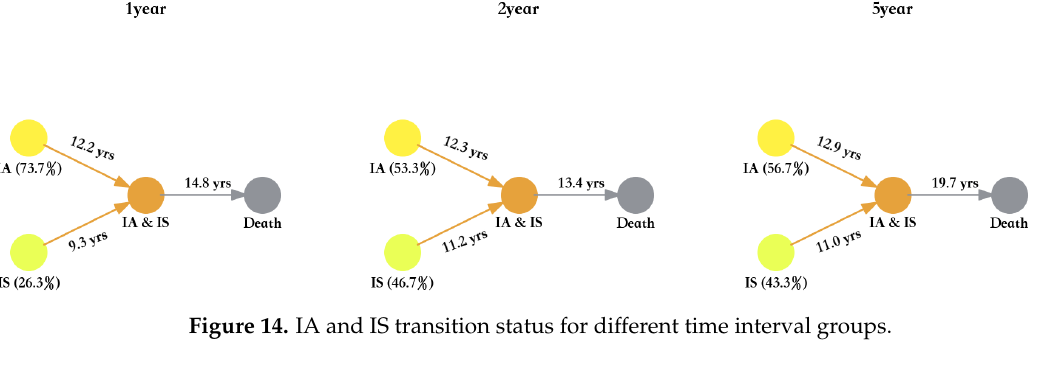
Figure 14. IA and IS transition status for different time interval